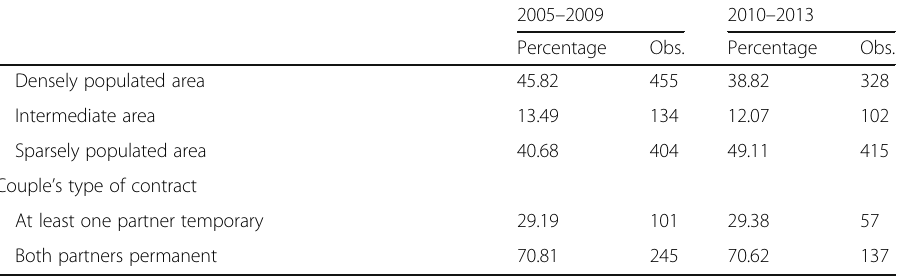
Table 3 Descriptive statistics for the variables used in the study according to time period (2005 –